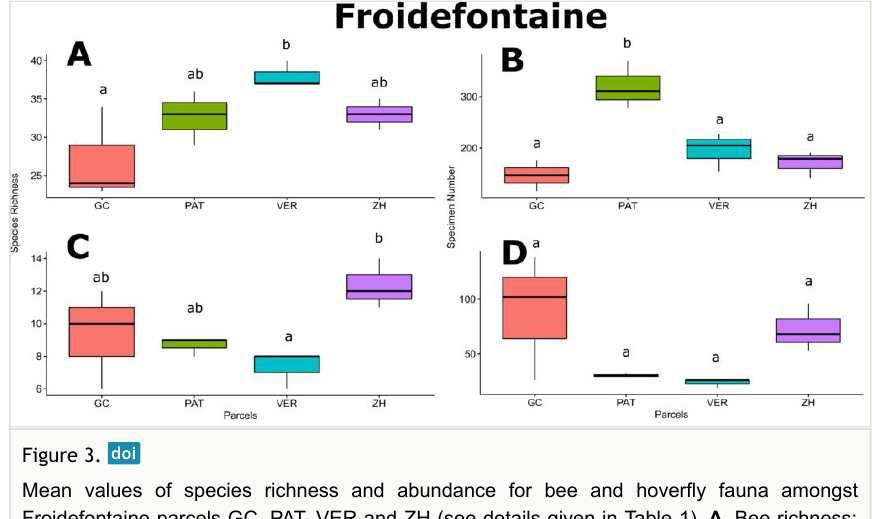
Figure 3. Mean values of species richness and abundance for bee and hoverfly fauna amongst Froidefontaine parcels GC, PAT, VER and ZH (see details given in Table 1). A. Bee richness; B. Bee abundance; C. Hoverfly richness; D. Hoverfly abundance. Letters above the boxplots represent Tukey's post-hoc comparisons.